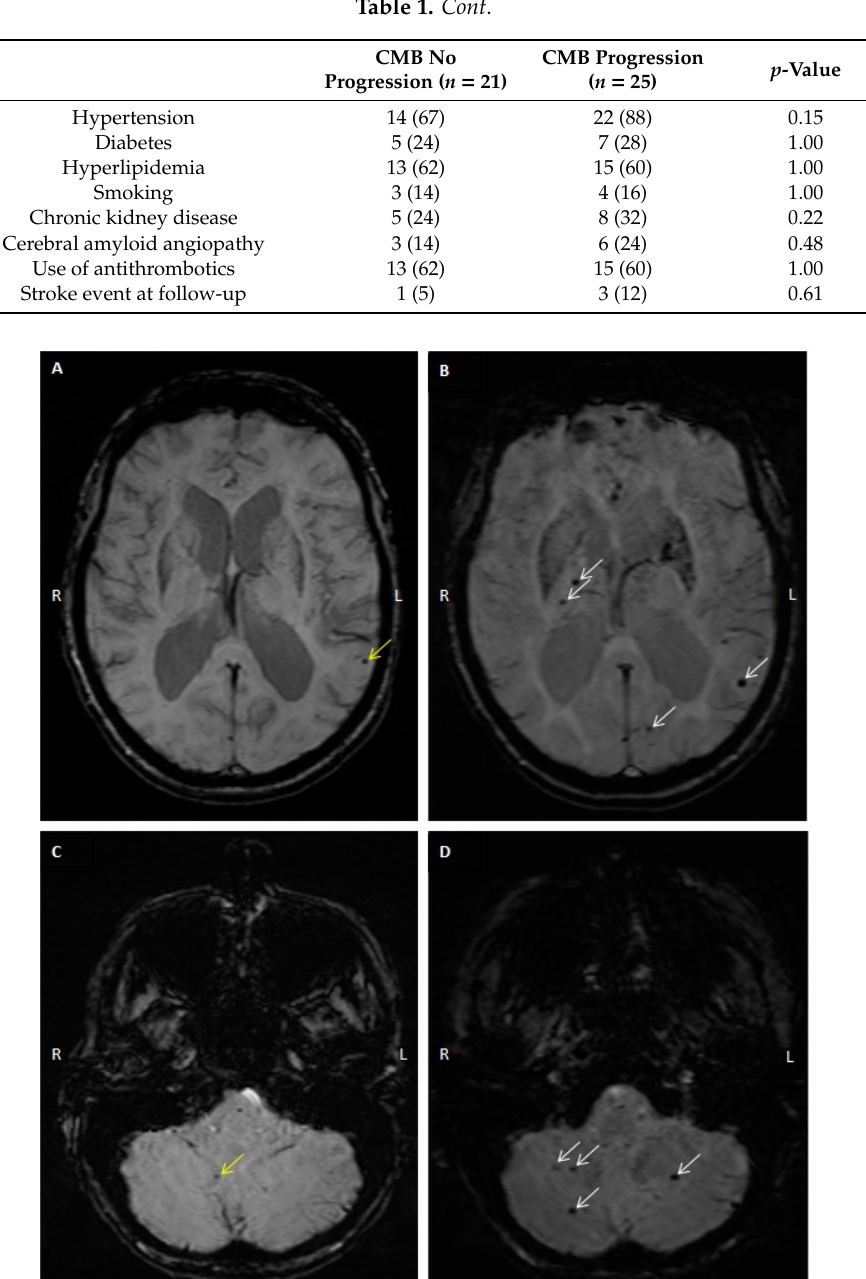
Figure 1. Baseline and follow-up axial susceptibility-weighted images showing CMB count progression. Axial SWI from the same individual showing cerebral microbleeds (CMB) in two sections at the initial visit shown in ( A , C ), and at the follow-up visit 36 months later shown in ( B , D ). ( A ) Left lobar microbleed (yellow arrow). ( B ) New right thalamic and left lobar microbleeds (white arrows). ( C ) Right cerebellar microbleed (yellow arrow). ( D ) New cerebellar microbleeds (white arrows).